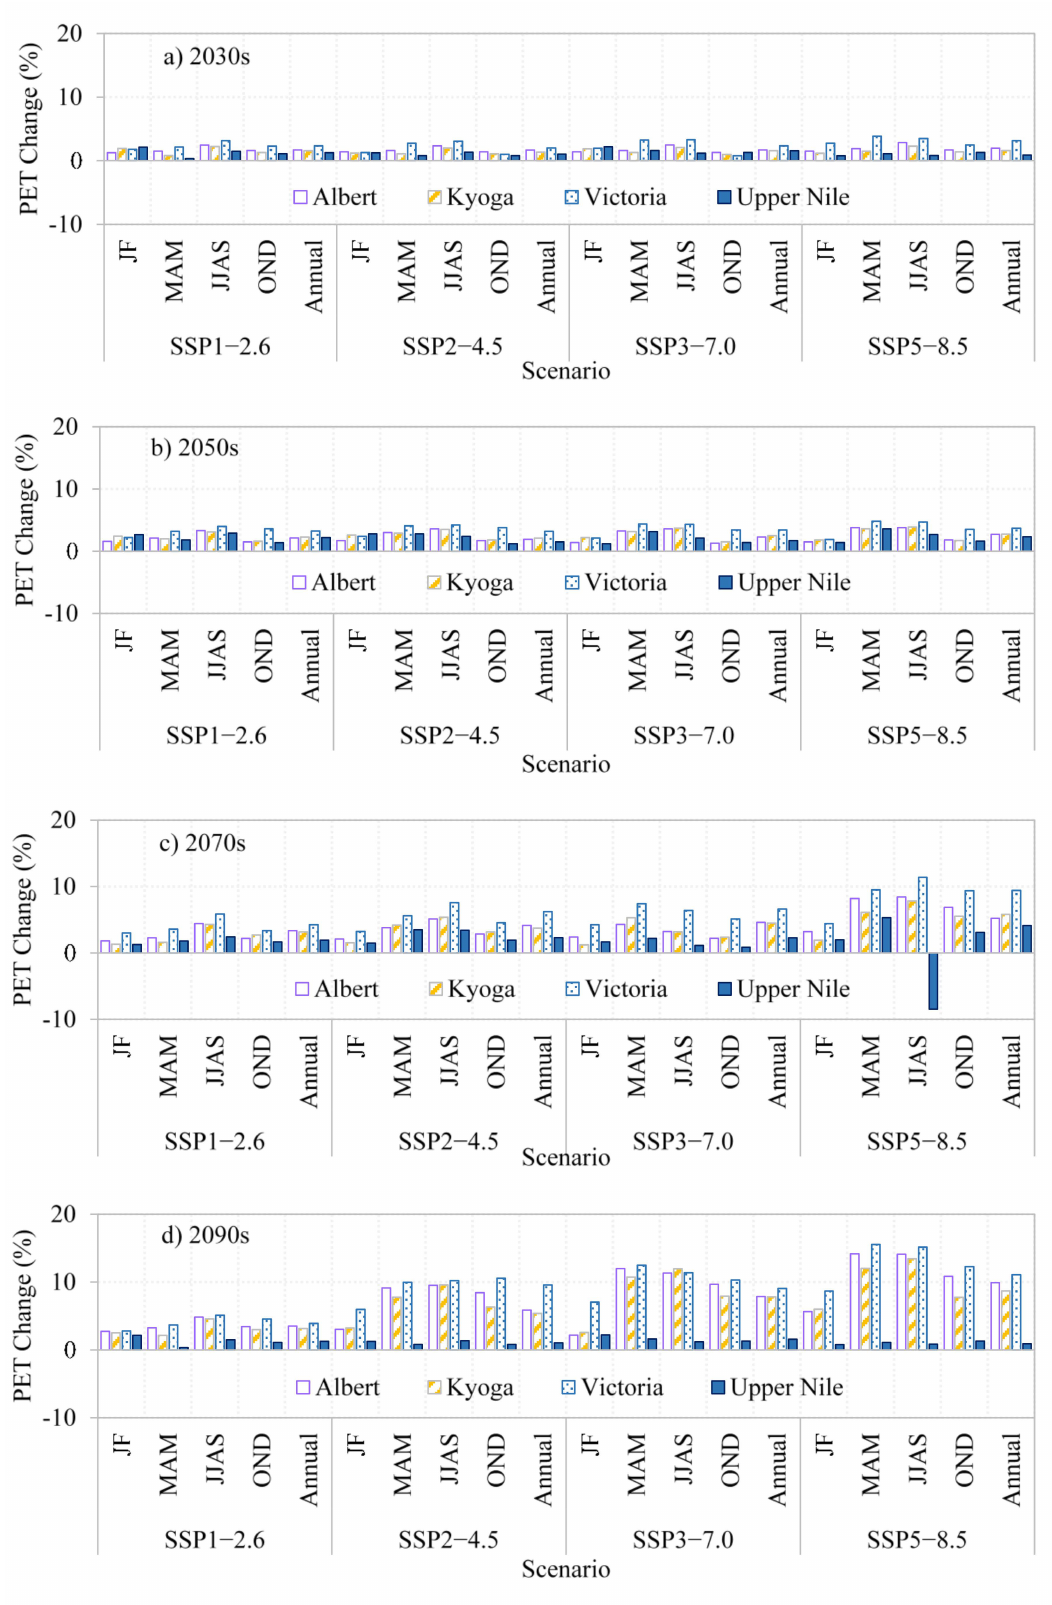
Figure 6. Projected changes in PET averaged over each WMZ during the ( a ) 2030s, ( b ) 2050s, ( c ) 2070s, and ( d )